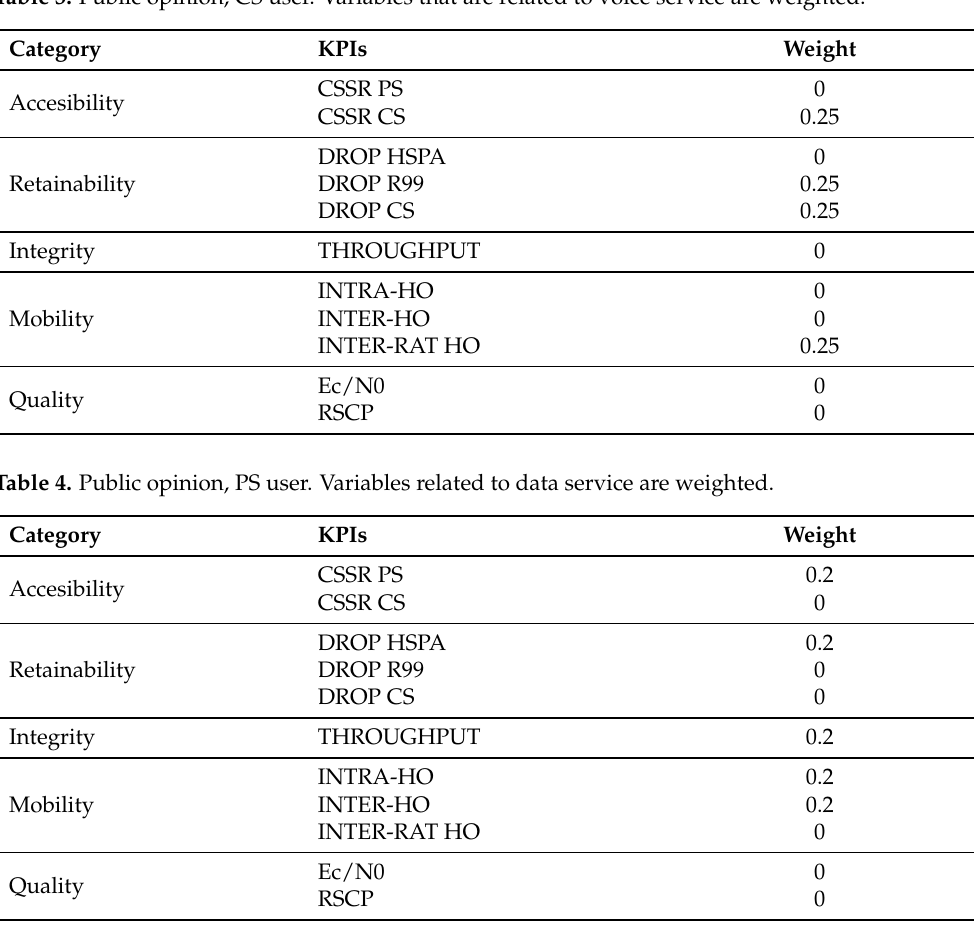
Table 3. Public opinion, CS user. Variables that are related to voice service are weighted.